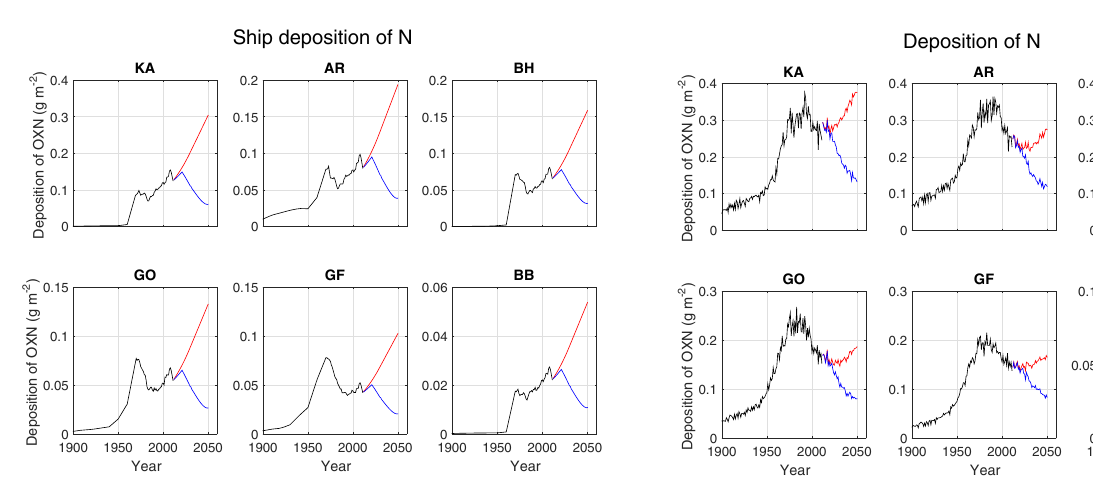
Figure 8. Annual ship deposition of nitrogen (gm − 2 ) in six basins of the Baltic Sea (defined in Fig. 2), for the years 1900 to 2050. The red line corresponds with shipping scenarios 1 to 3 and the black line corresponds with historical shipping (derived in Omstedt et al., 2015). The blue line includes the implementation of TIER II and a NECA.